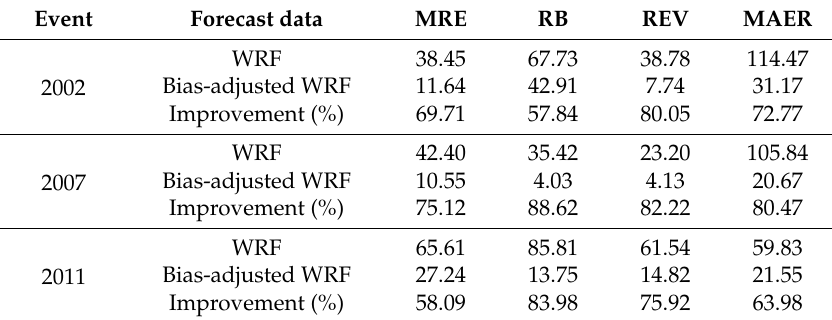
Table 3. Results of the improvements to the flood events in 2002, 2007 and